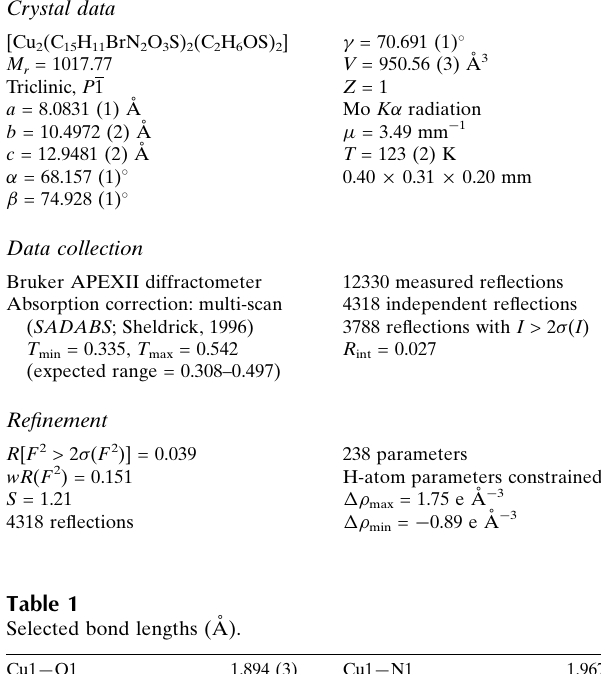
Selected bond lengths (A˚